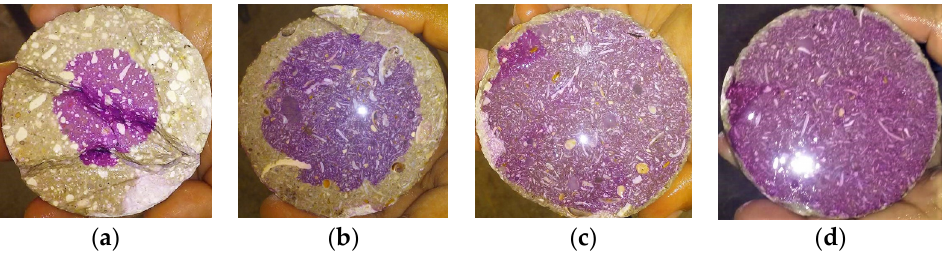
Figure 5. Carbonation of concrete samples: ( a ) control, ( b ) 0.05%, ( c ) 1%, and ( d ) 2%.